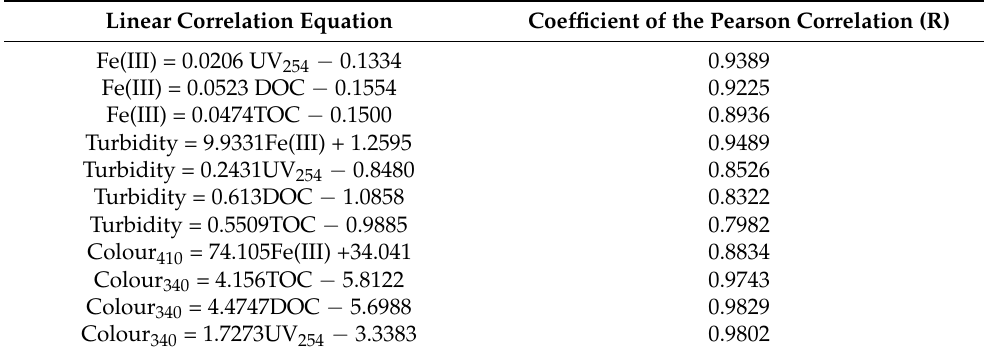
Table 4. Parameters of linear correlations between the iron (III), turbidity, and the organic matter indices of the water samples after